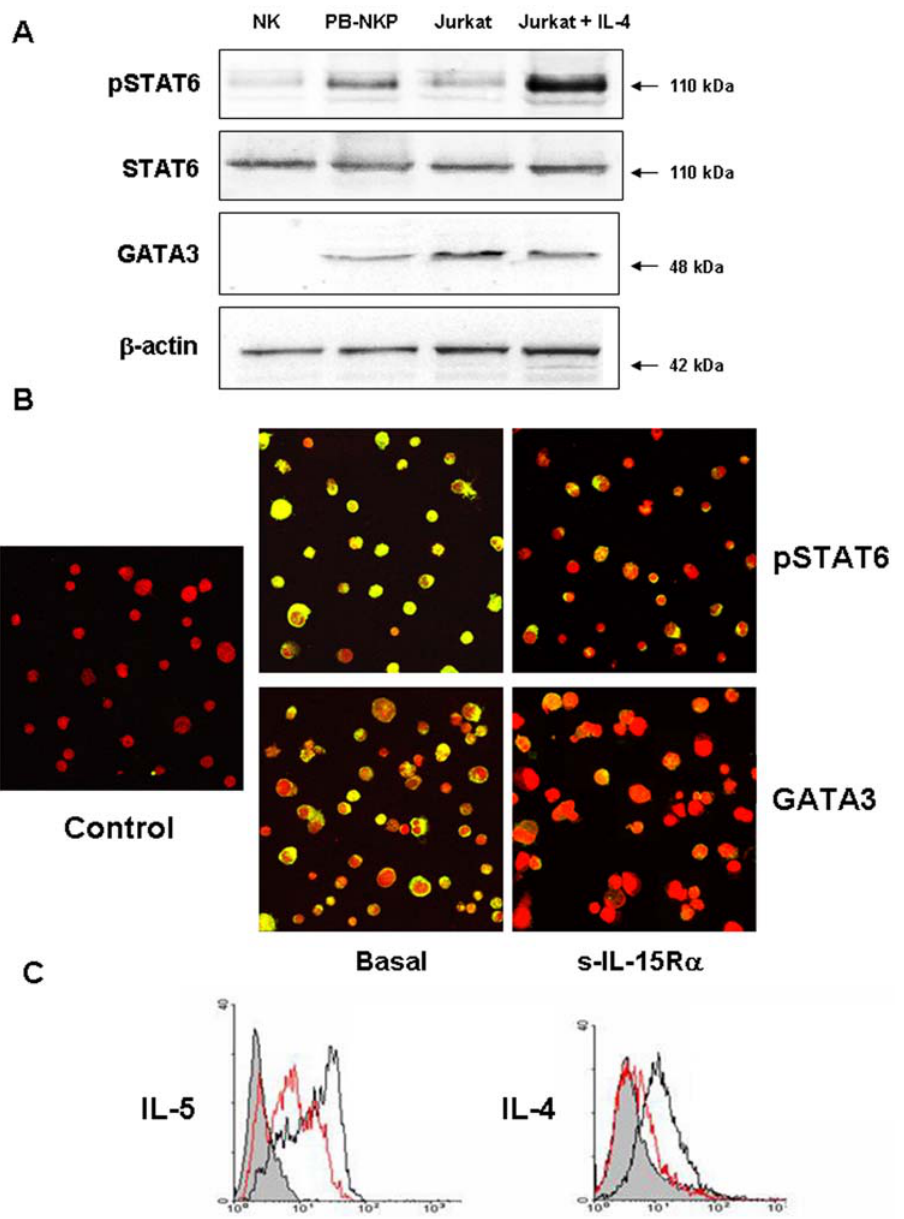
Figure 4. Autonomous NK commitment of PB-HP: expression of Th2 transcription factors. (A) Western blotting detects a specific 110 kDa band for pSTAT6 and a specific 48 kDa for GATA3 in the cell total lysate of PB-NKP but not of conventional NK cells. GATA3 + Jurkat cells stimulated with IL-4 were used as controls. (B Left panels) The expression of activated STAT6 and GATA3 was further confirmed, checking by confocal microscopy the nuclear localization of phospho-STAT6 and GATA3 (yellow staining) in PB-NKP. These cells were fixed, permeabilized, and stained for phopho-STAT6 or GATA3 transcription factors (green). Nuclei were stained by propidium iodide (red). As negative controls, cells were incubated with rabbit IgG, the second reagent, and propidium iodide. (B Right panels) Effects of 24 hours pre-incubation of PB-NKP with the soluble IL-15R a chain (100 ng/ml for 60 min.) on the nuclear localization of phopho-STAT6 or GATA3. (C) Effects of 24 hours pre-incubation with the soluble IL-15R a chain on the intracellular production of the Th2 cytokines IL-5 and IL-4 in PB-NKP. Intracellular expression of cytokines (continuous black lines) is blocked adding the soluble IL-15R a chain (continuous red line) for 24 hours. Isotype controls (shadowed peaks).